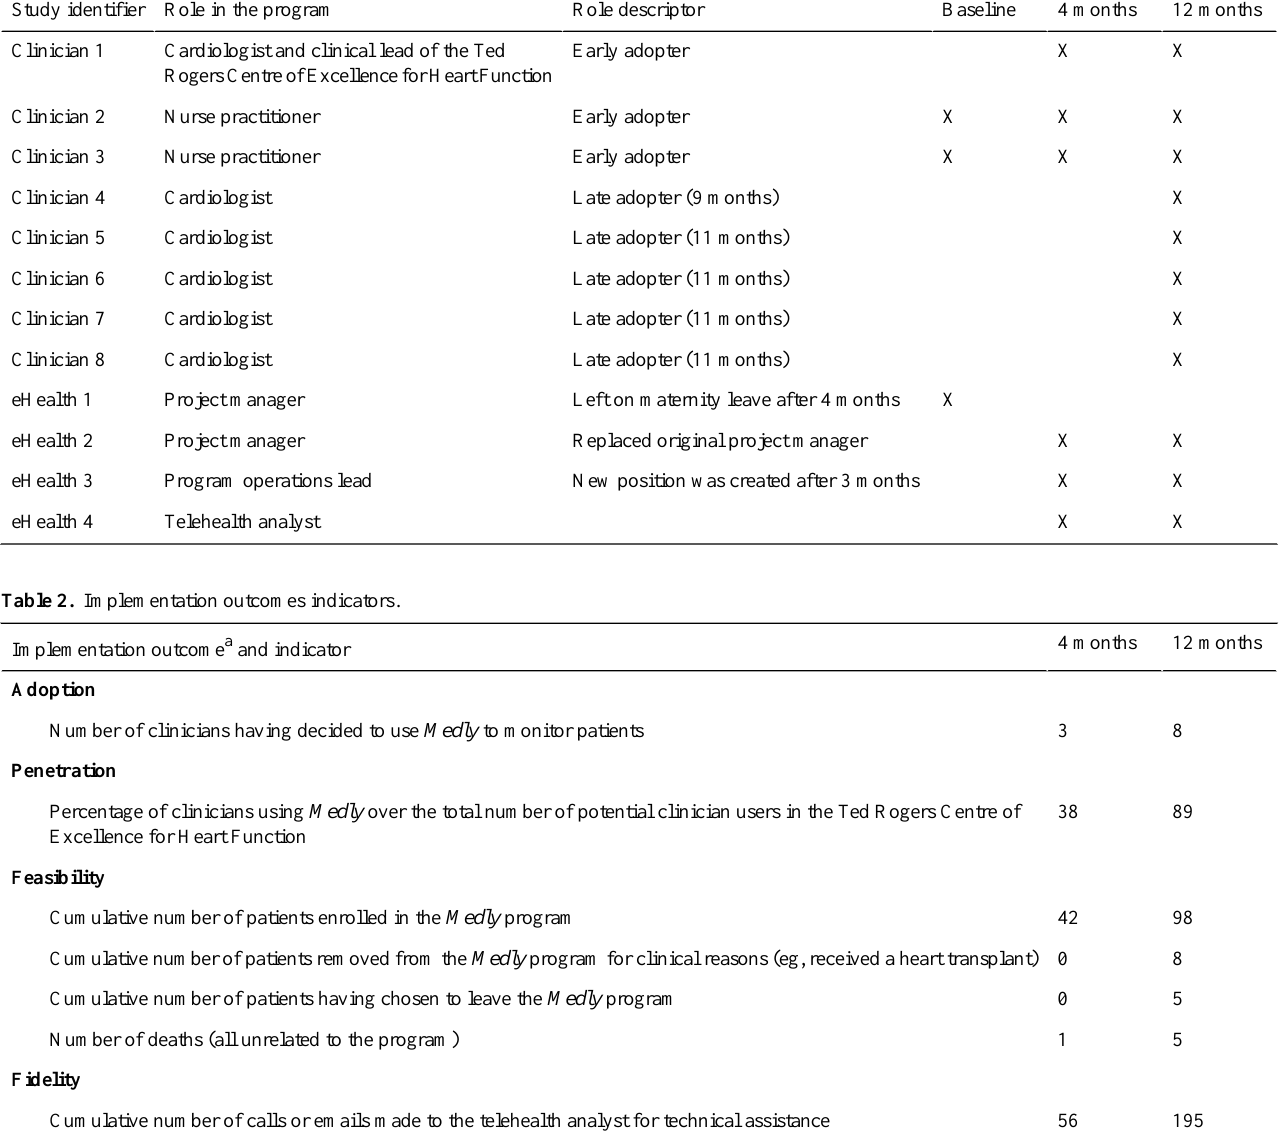
12 months4 monthsBaselineRole descriptorRole in the programStudy identifier